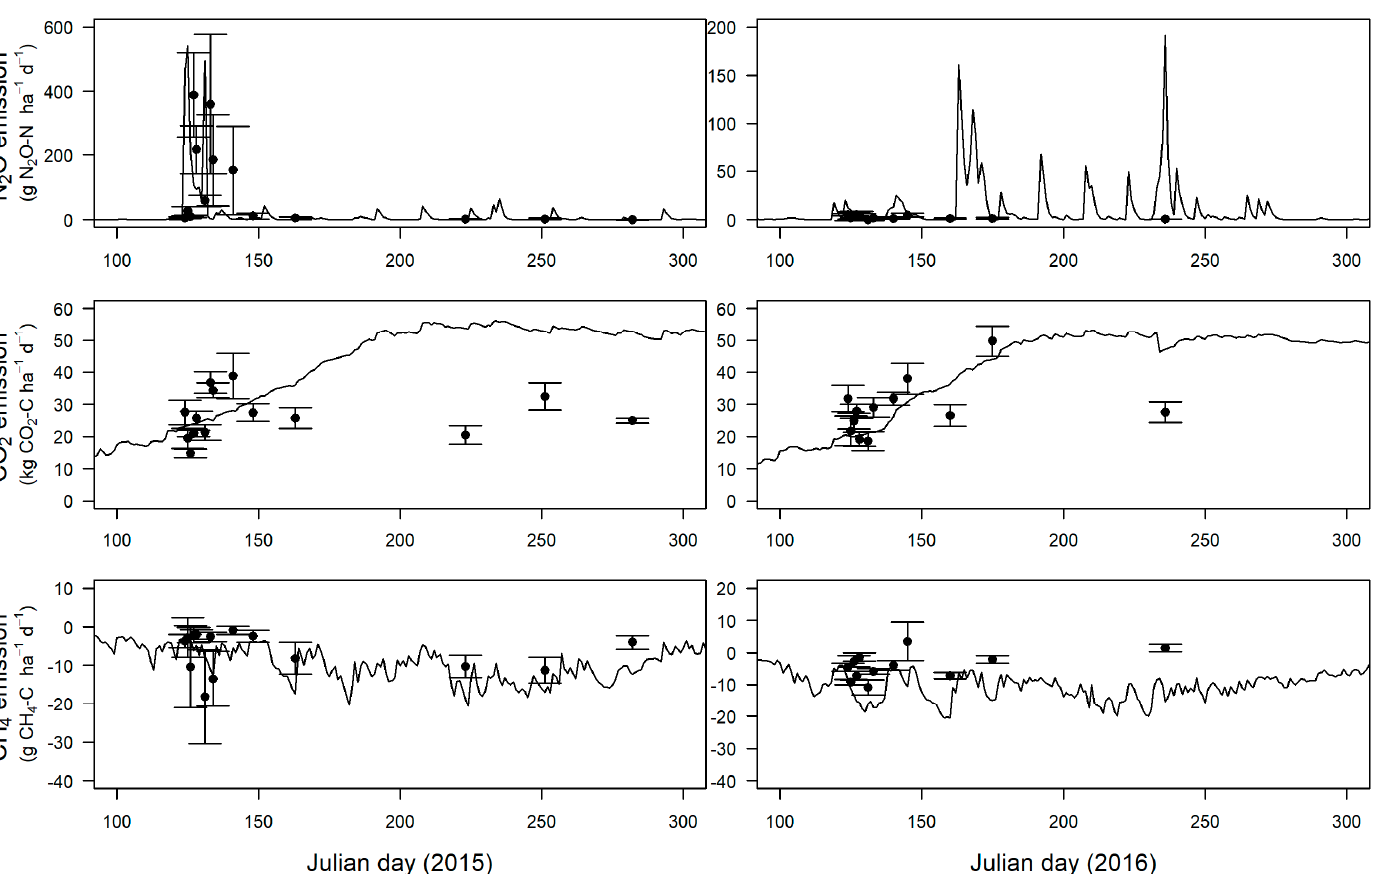
Figure 4. Measured (filled circle) and simulated (solid line) N 2 O, CO 2 and CH 4 emissions from soils of the interaction between nitrogen and warming treatment for 2015 and 2016 growing seasons. Error bars are standard deviations for 5 replicates.